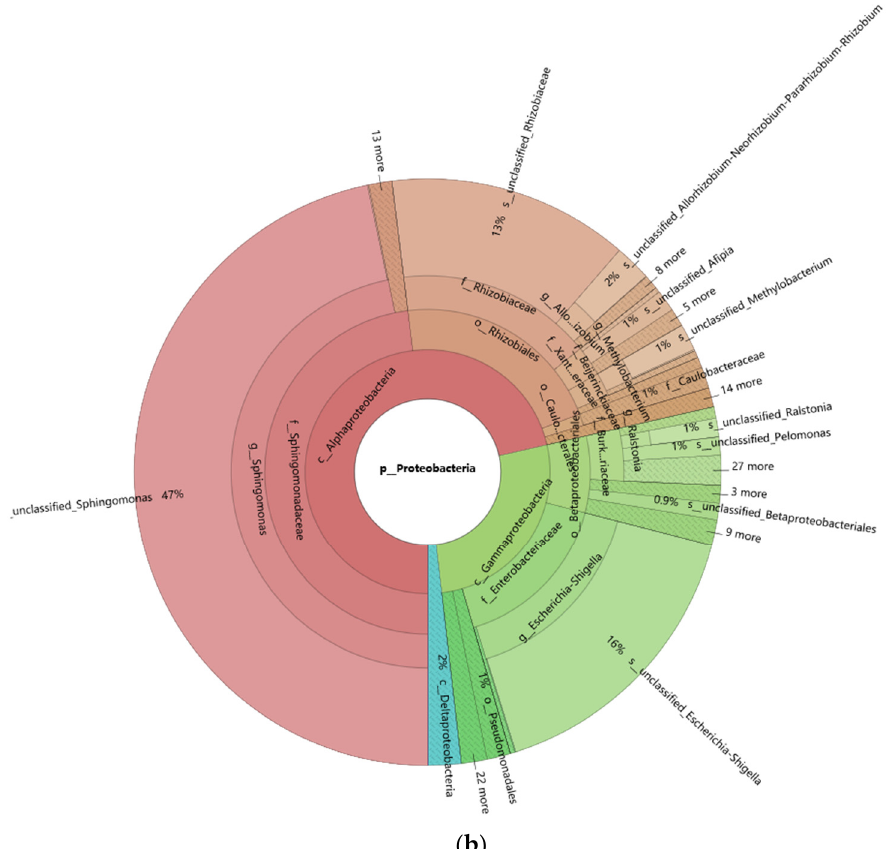
Figure 10. Community structure and relative abundance of microorganisms after domestication ( a ). Community and relative abundance of Proteobacteria microorganisms after domestication ( b ).